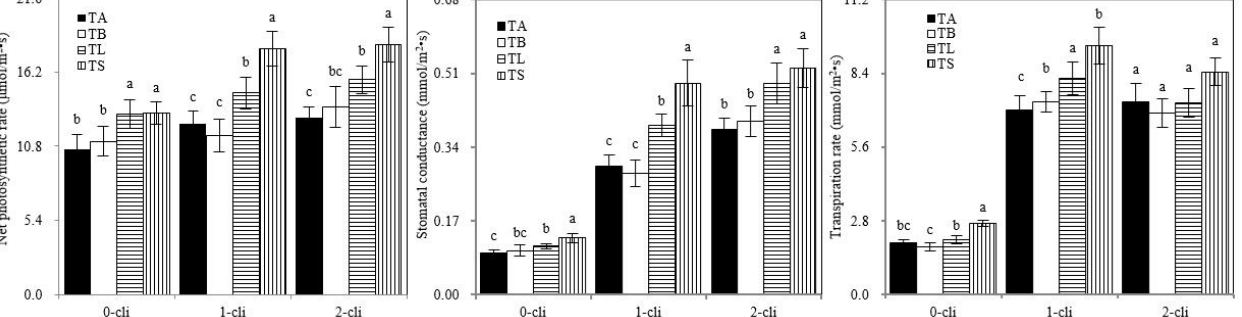
Figure 6. Net photosynthetic rate, transpiration rate, and stomatal conductance of Italian ryegrass in the different treatments in the experiment. TA, TB, TS, TL indicate treatments of regrowth with liquid medium without AOB added relatively long before defoliation, regrowth with liquid medium without AOB added shortly before defoliation, regrowth with S2_8_1 strain inoculated relatively long before defoliation, and regrowth with S2_8_1 strain inoculated shortly before defoliation, respectively. “0-cli”, “1-cli” and “2-cli” mean, respectively, days 0, 7 and 14 after defoliation. The values are the mean ± standard error (n = 3). The different letters in each row indicate significant differences ( p < 0.05).